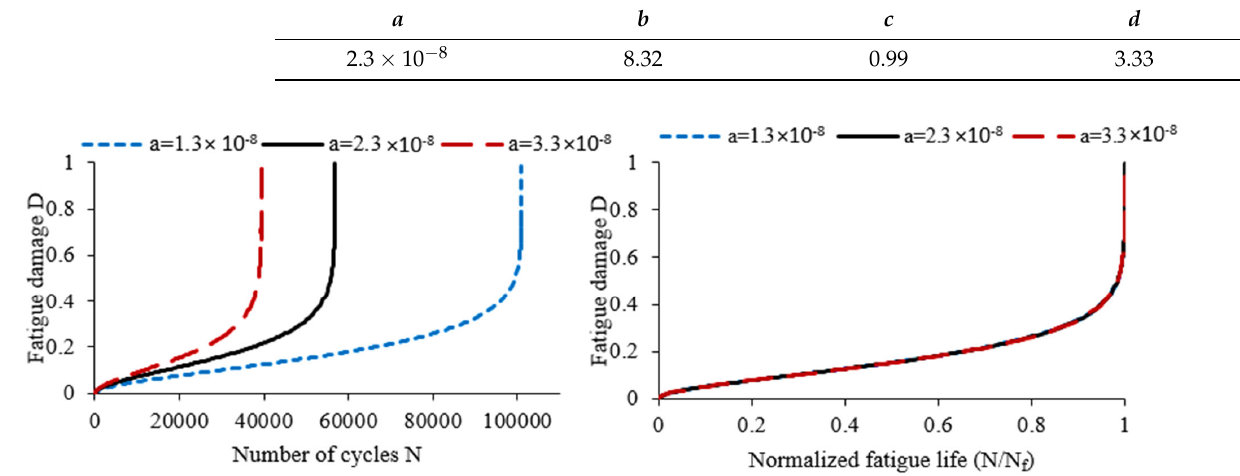
of damage. This parameter is responsible for initiating damage during the third stage.